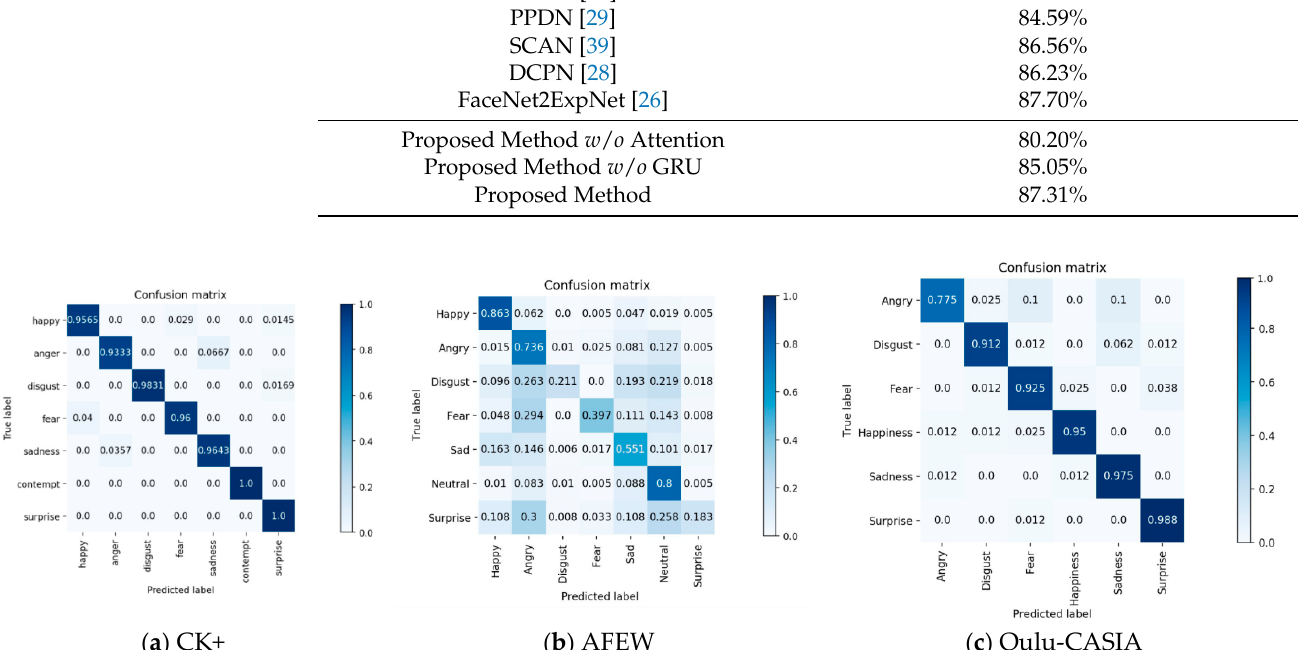
Figure 7. Confusion matrix of networks on CK+, AFEW, and Oulu-CASIA datasets.